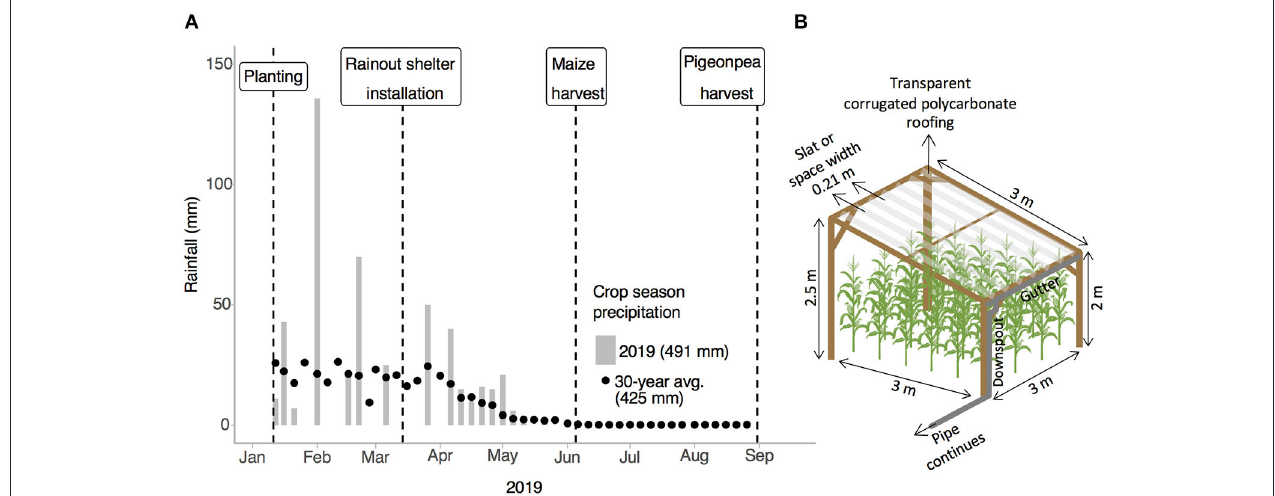
FIGURE 1 | (A) Drought experiment timeline and cropping season rainfall for the experiment and 30-year average (1988–2018). Total cropping season rainfall is indicated in parentheses in the figure legend. (B) Diagram of rainout shelter designed to intercept 50% of incoming rainfall. The pipe drainage system carries water to the field border. Shelters were bordered by a short (40cm) bund of field soil to prevent surface runoff into the drought plots during rainfall events. Post burial depth (not pictured) was 0.5m. Plant density not to scale (2 plants per hill). Photographs of shelters are provided in Supplementary Figure 3 .